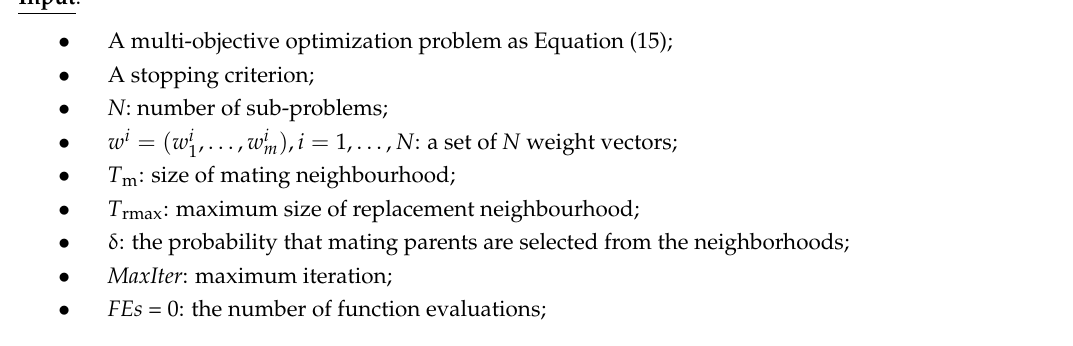
Algorithm 1. MOEA/D